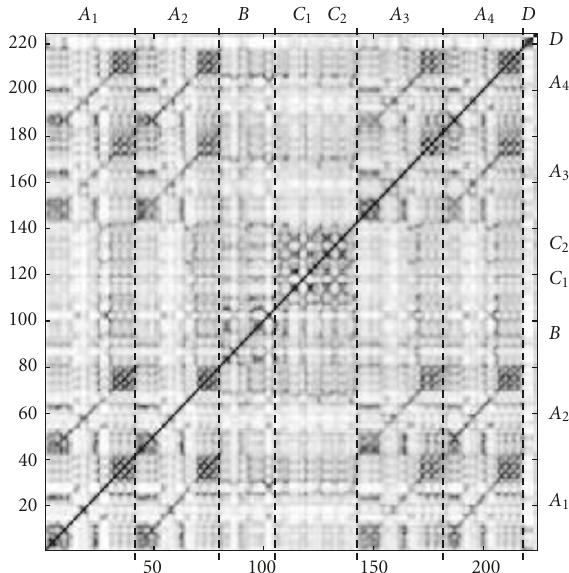
Figure 2: Self-similarity matrix S [41,10] of a Chailly interpreta- tion of Shostakovich’s Waltz 2, Jazz Suite no. 2, having the musical form A 1 A 2 BC 1 C 2 A 3 A 4 D . Due to significant variations in the audio recording, the path structure is fragmented and of low quality. See also Figure